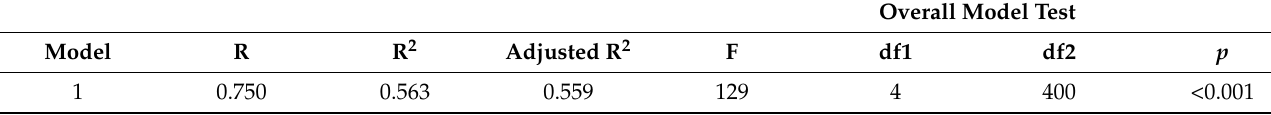
Table 5. Model fit measures.